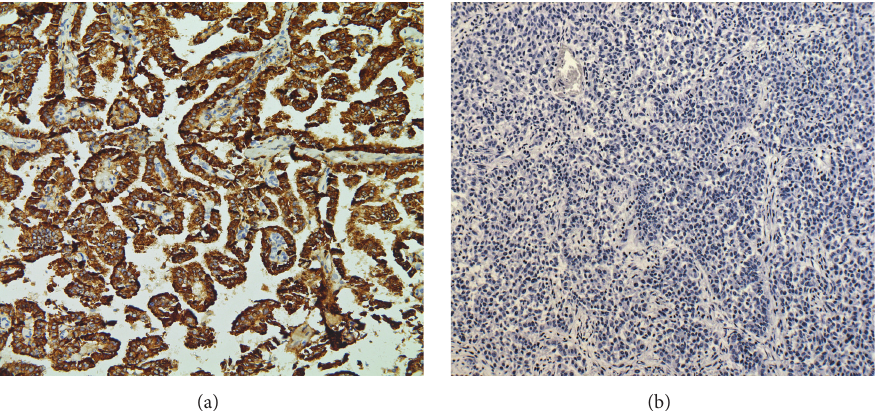
Figure 4: (a) 20x: Napsin-A immunohistochemical stain depicting a focus of diffuse cytoplasmic staining. (b) 20x: thyroglobulin immuno- histochemical stain which is negative in the tumor.